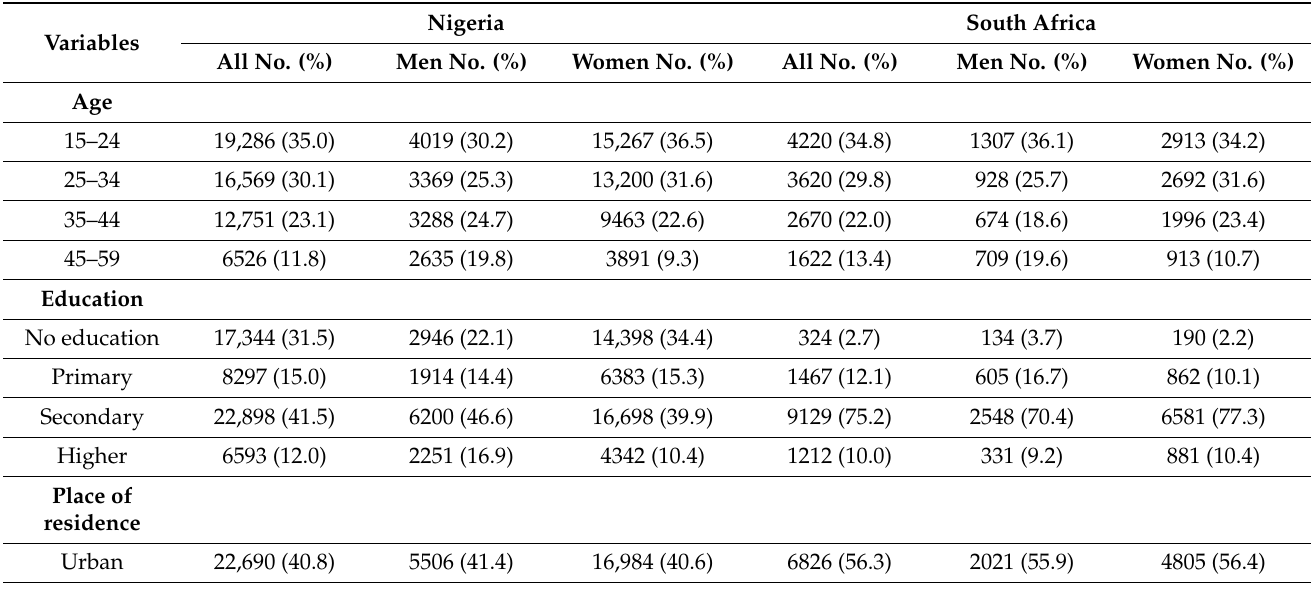
Table 2. Distribution of the population by socio-demographic characteristics, stratified by sex in South Africa and